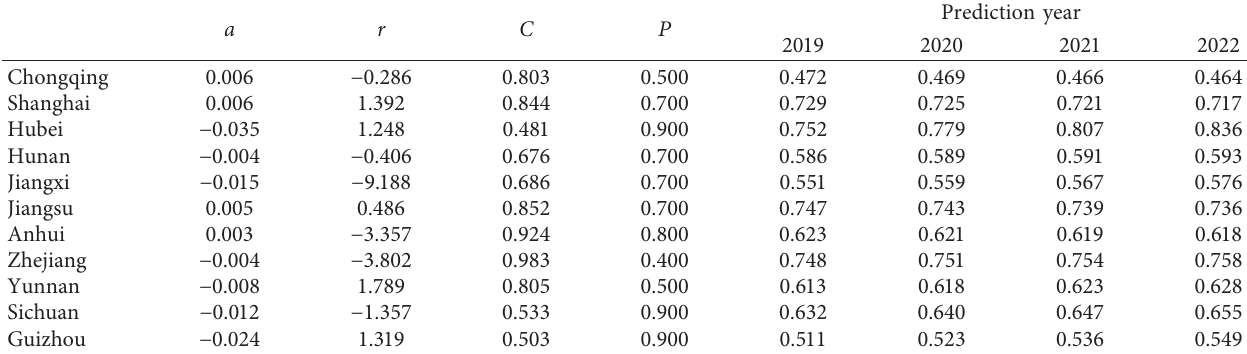
Table 7: Prediction of